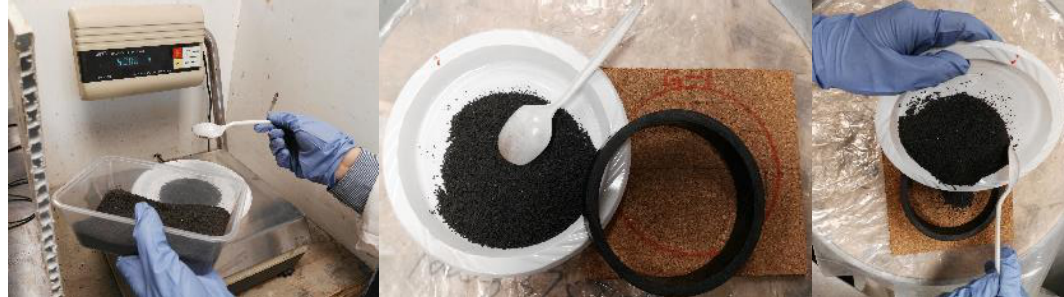
Figure 14. Preparation of test samples.